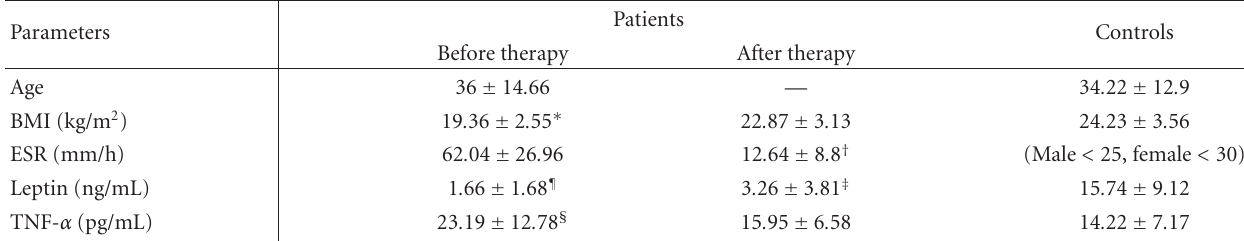
Table 2: Age, ESR, BMI, leptin, and TNF- α in controls and patients before and after tuberculosis therapy. Data presented as mean ± SD.